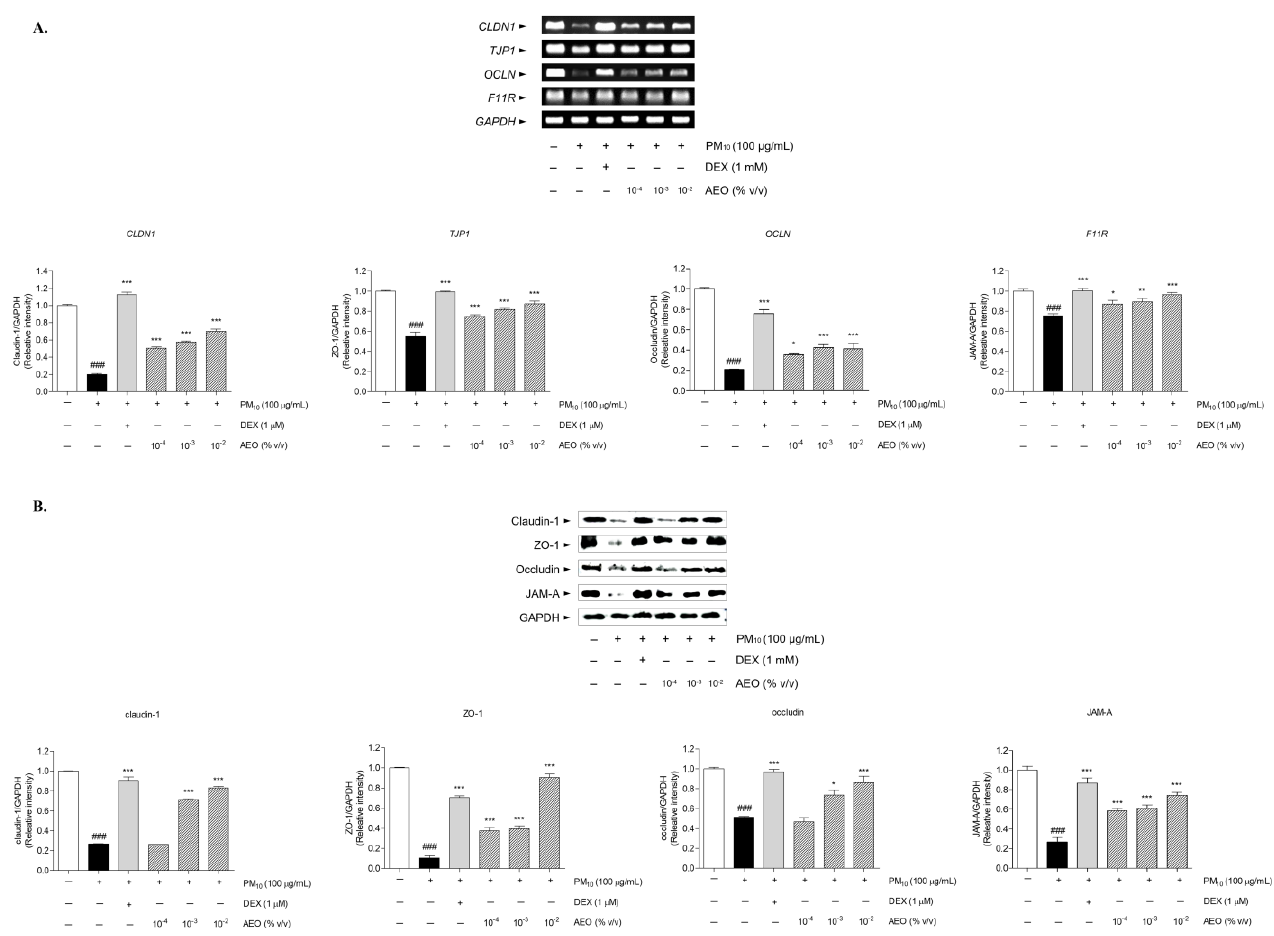
Figure 10. Expressions of tight junction-related factors in PM 10 -treated nasal epithelial cells. AEO increased mRNA expression levels of CLD1 (Claudin-1), TJP1 (ZO-1), OCLN (Occludin), and F11R (JAM-A) in PM 10 -induced human nasal epithelial cells ( A ). AEO increased protein expressions of ZO-1, Claudin-1, Occludin, and JAM-A PM 10 -induced human nasal epithelial cells ( B ). The data are presented as the mean ± means ± standard error of the mean. ### p < 0.001 compared to the NOR group. * p < 0.05, ** p < 0.01, *** p < 0.001 compared to PM 10 -treated group.